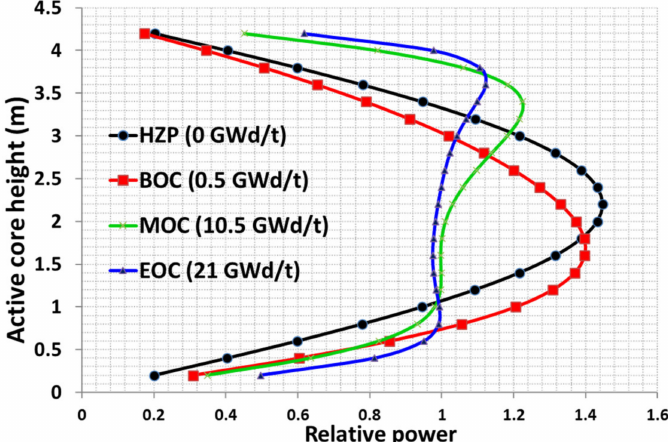
Figure 12. Simulated EPR 2.1 wt% assembly’s axial power profile (cycle 1, RCCA out, modelled in 21 axial layers, incorporating spatial burnup and thermal-hydraulic